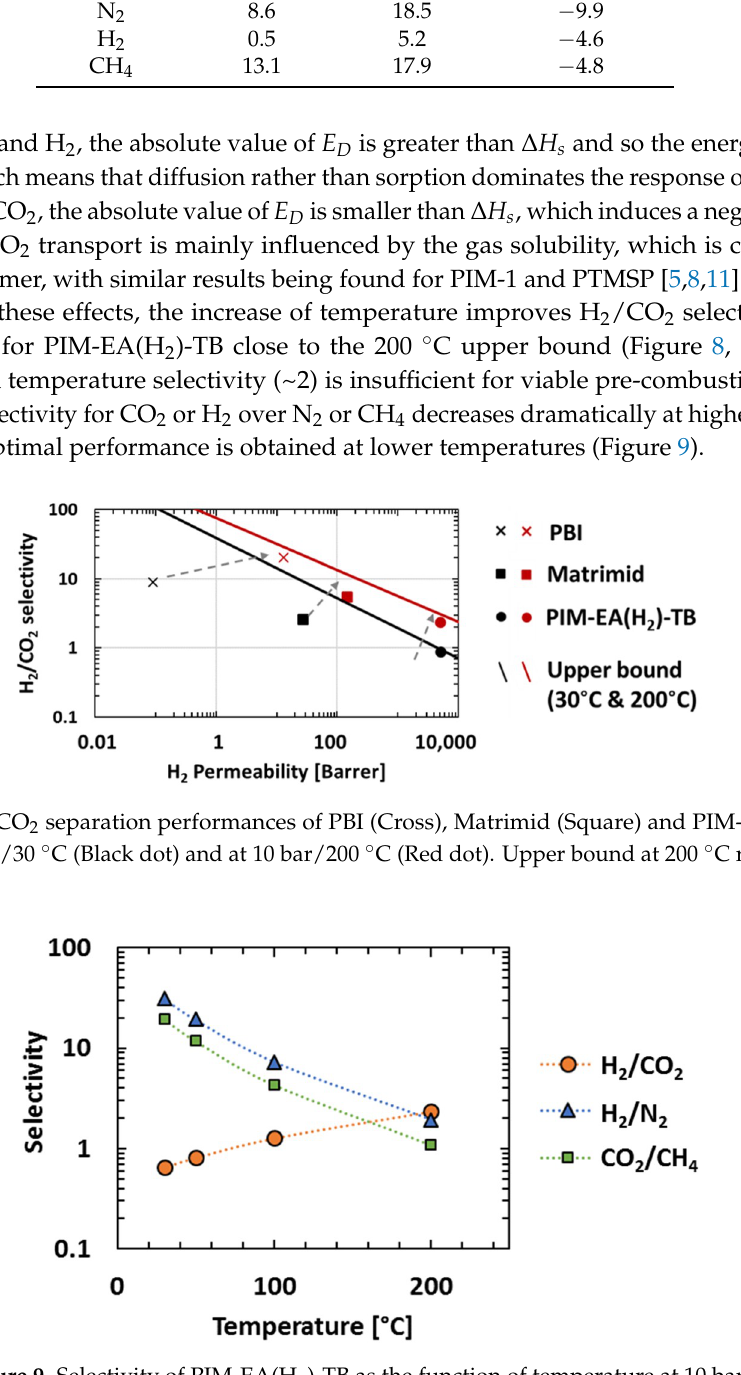
Figure 9. Selectivity of PIM-EA(H 2 )-TB as the function of temperature at 10 bar.